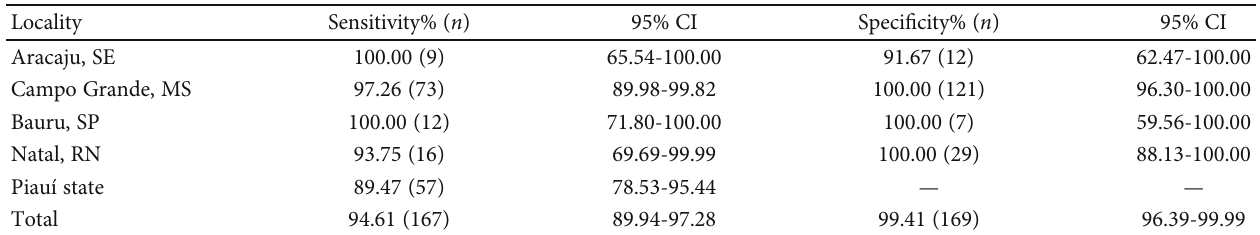
Figure 7: Cross-reactivity of DTL-4-ELISA with sera from patients diagnosed with other diseases. Sera from patients previously diagnosed with tegumentary leishmaniasis, Chagas ’ disease, malaria, toxoplasmosis, rheumatoid factor, lupus, tuberculosis, syphilis, and paracoccidioidomycosis were submitted for DTL-4-ELISA assay. Sera from VL patients ( n = 155 ) and healthy donors ( n = 140 ) were also included in this assay. The dotted line represents the cut-o ff . Table 3: Performance of the DTL-4-ELISA in samples from patients with visceral leishmaniasis and negative controls from di ff erent geographical regions in Brazil.